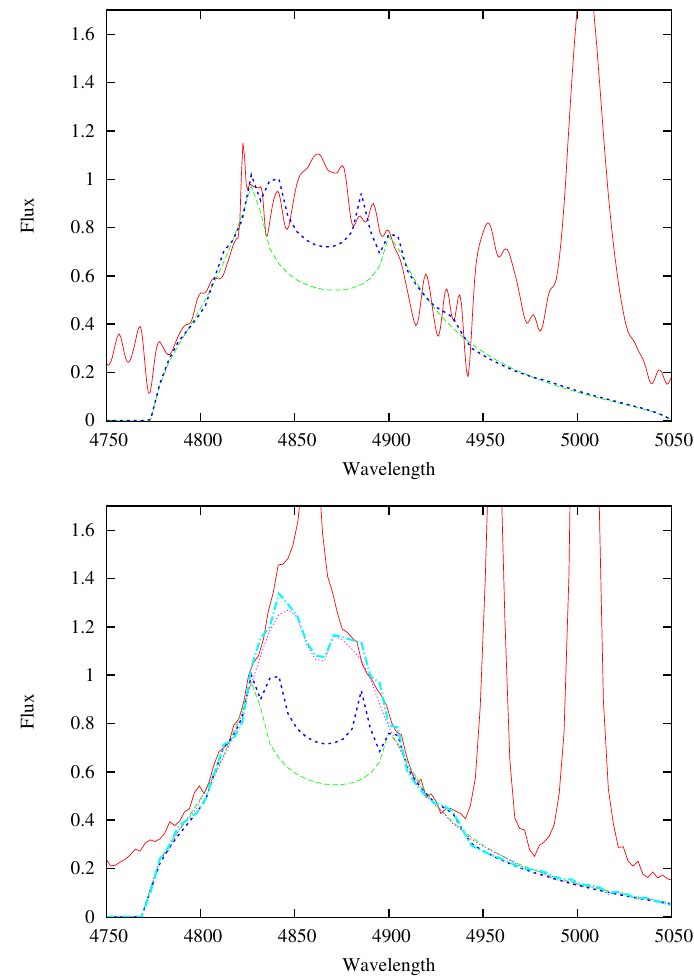
Figure 3. A few examples of AD + ring model matching the monitoring broad H β emission line profiles of a single object in low ( top panel) and high ( bottom panel) state. Both profiles are matched with models with same parameters, except for the outer radius, which is 1500 R g for the low state profile ( top ) and 8000 R g for the higher state line profile ( bottom panel). The model indicates that the difference between these two states is in ionization of outer BLR, with radii above 1500 R g